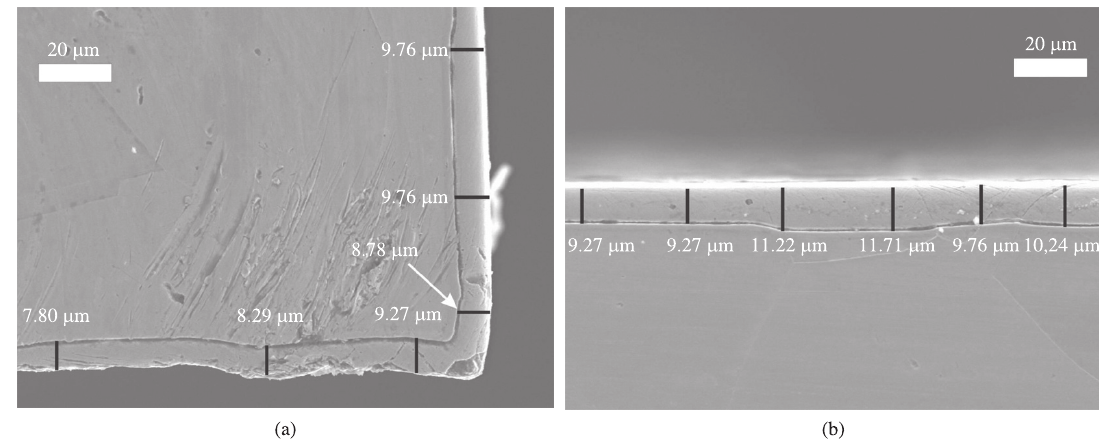
Figure 1. SEM micrographs of sample nitrided at 450 °C, for 5 h (a) near the edge, (b) in the central region.